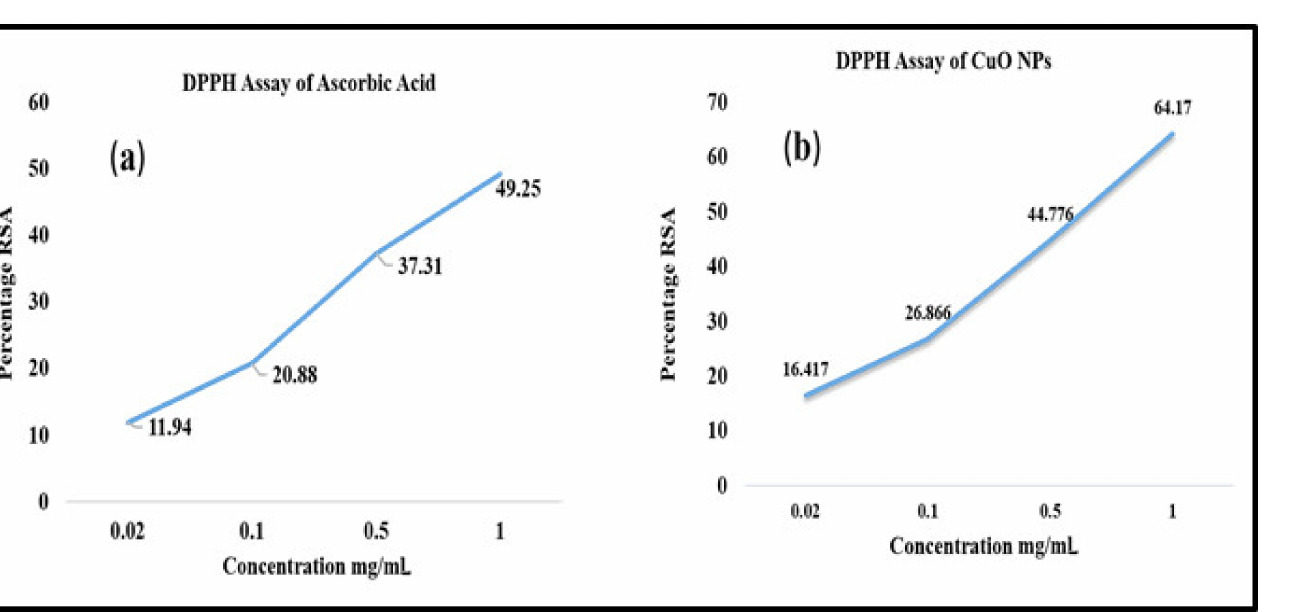
Figure 12. ( a ) Graphical representation of percentage RSA of ascorbic acid, ( b ) graphical representa- tion of RSA of CuO